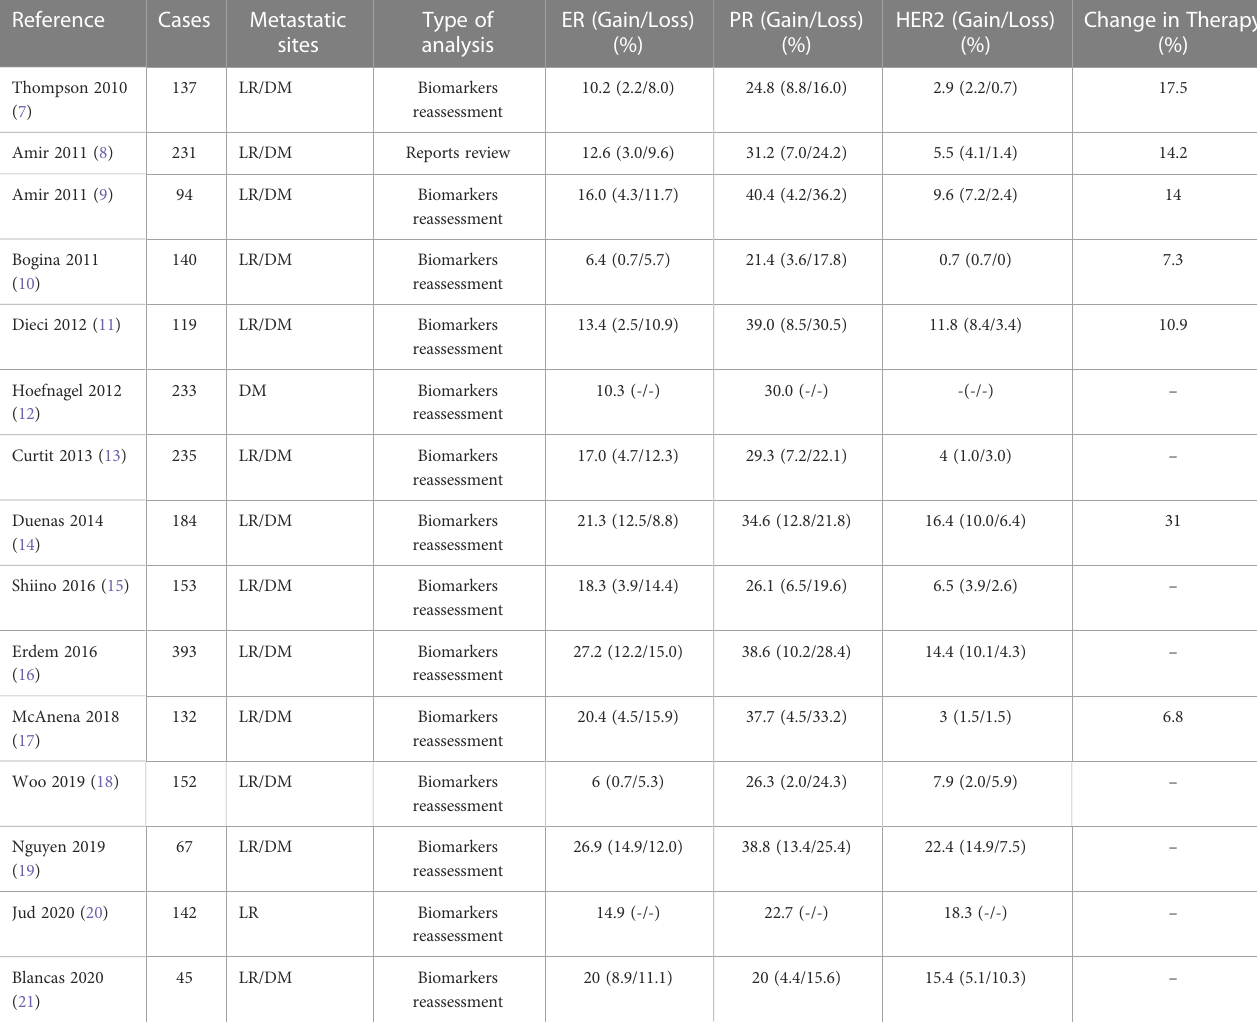
TABLE 1 Literature review of ER, PR and HER2 discordance between primary tumors and corresponding metastatic sites.